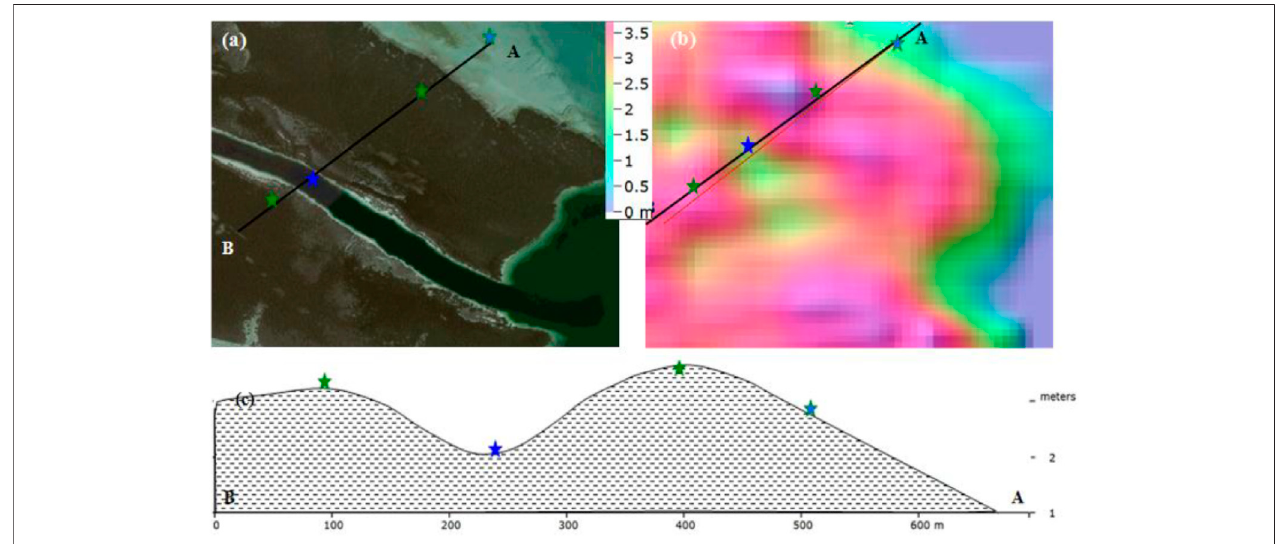
FIGURE14| Zoom ofthe QuickBirdimagefor AbuDhabi mangrove (A) , shaded relief generated fromthe ALOSDEM (B) ,and topographicpro fi le (C) showing the spatial relationship between topography of mud fl at and distribution of mangroves.